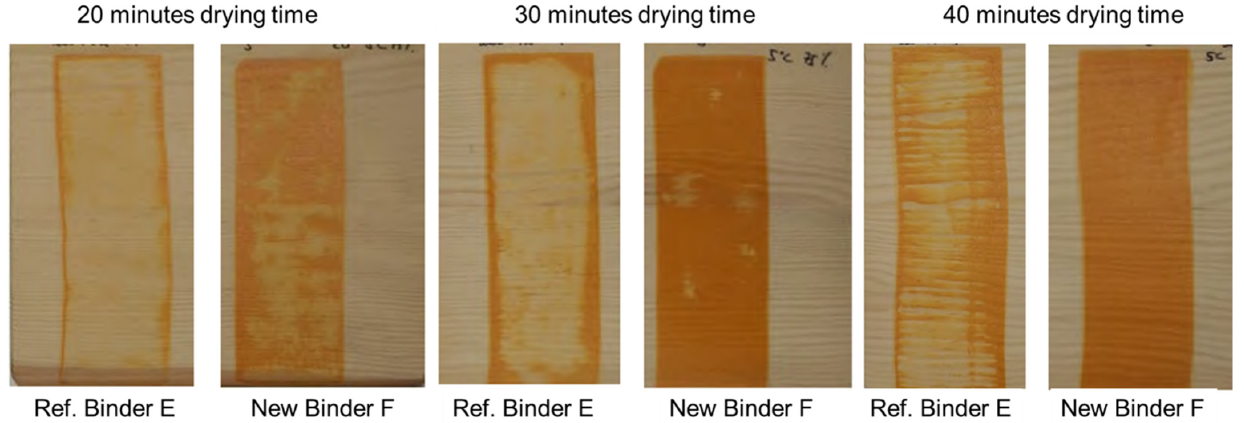
Figure 1. Criteria for all-season paints.